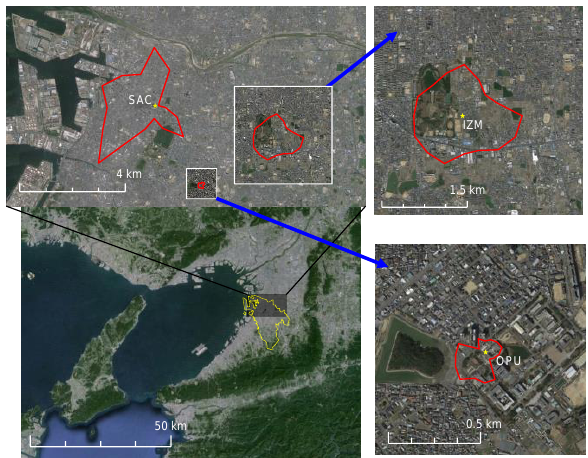
Figure 1. Aerial photograph by Google Earth showing the study area, where the 80% flux footprint in daytime is shown with red lines. The boundary of Sakai City is shown as a yellow